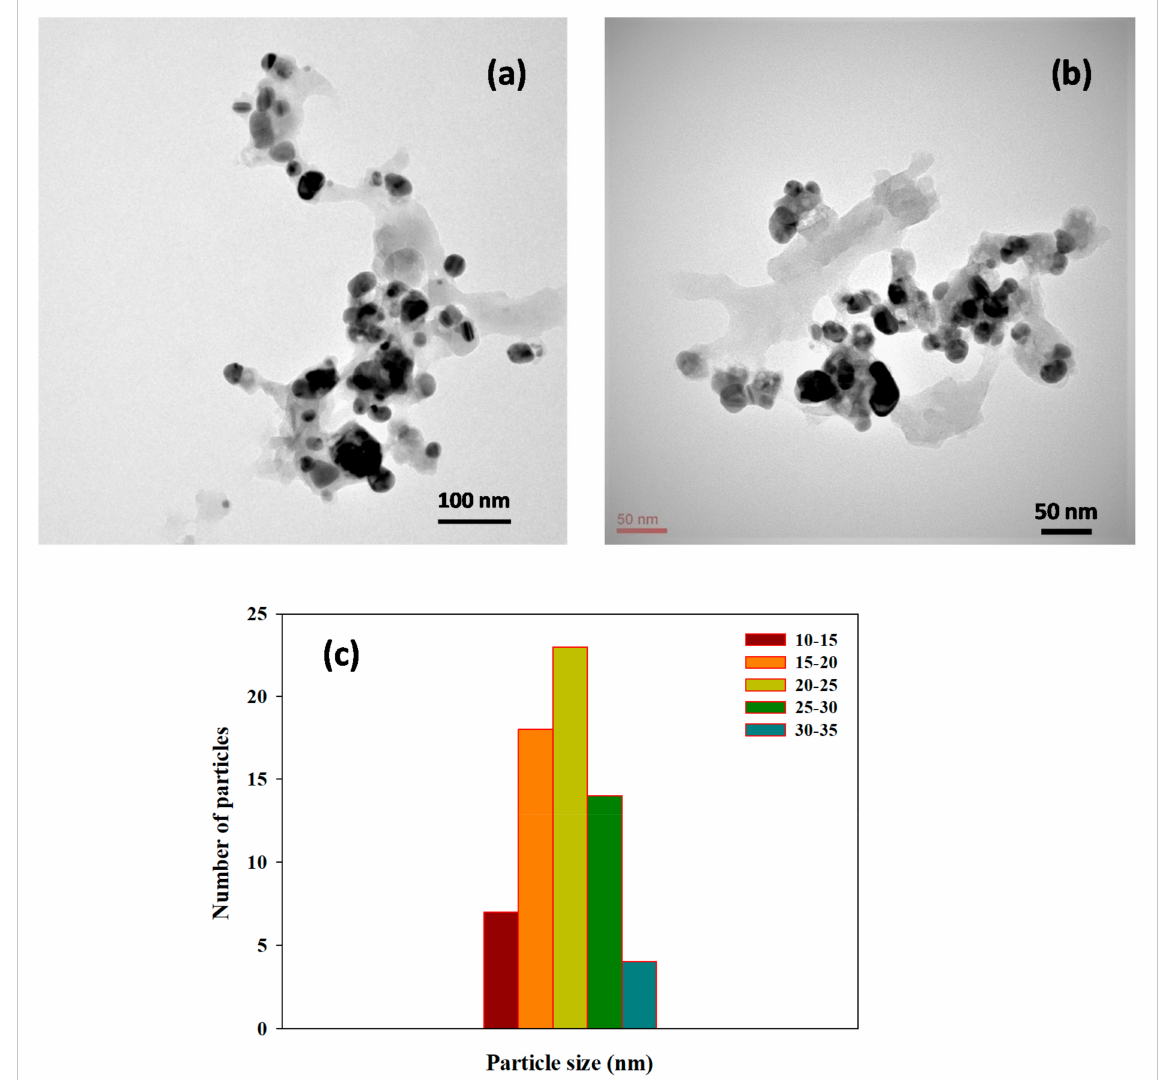
Figure 5. HR-TEM images of LS–Ag NPs: ( a ) at 100 nm; ( b ) at 50 nm amplification; and ( c ) average particle-size histogram of the LS–Ag NPs produced under optimized